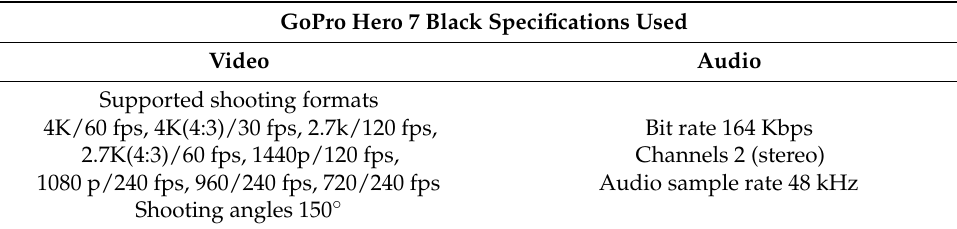
Table 2. Audio and video specification of GoPro Hero 7 Black camera(s) used during data collection.